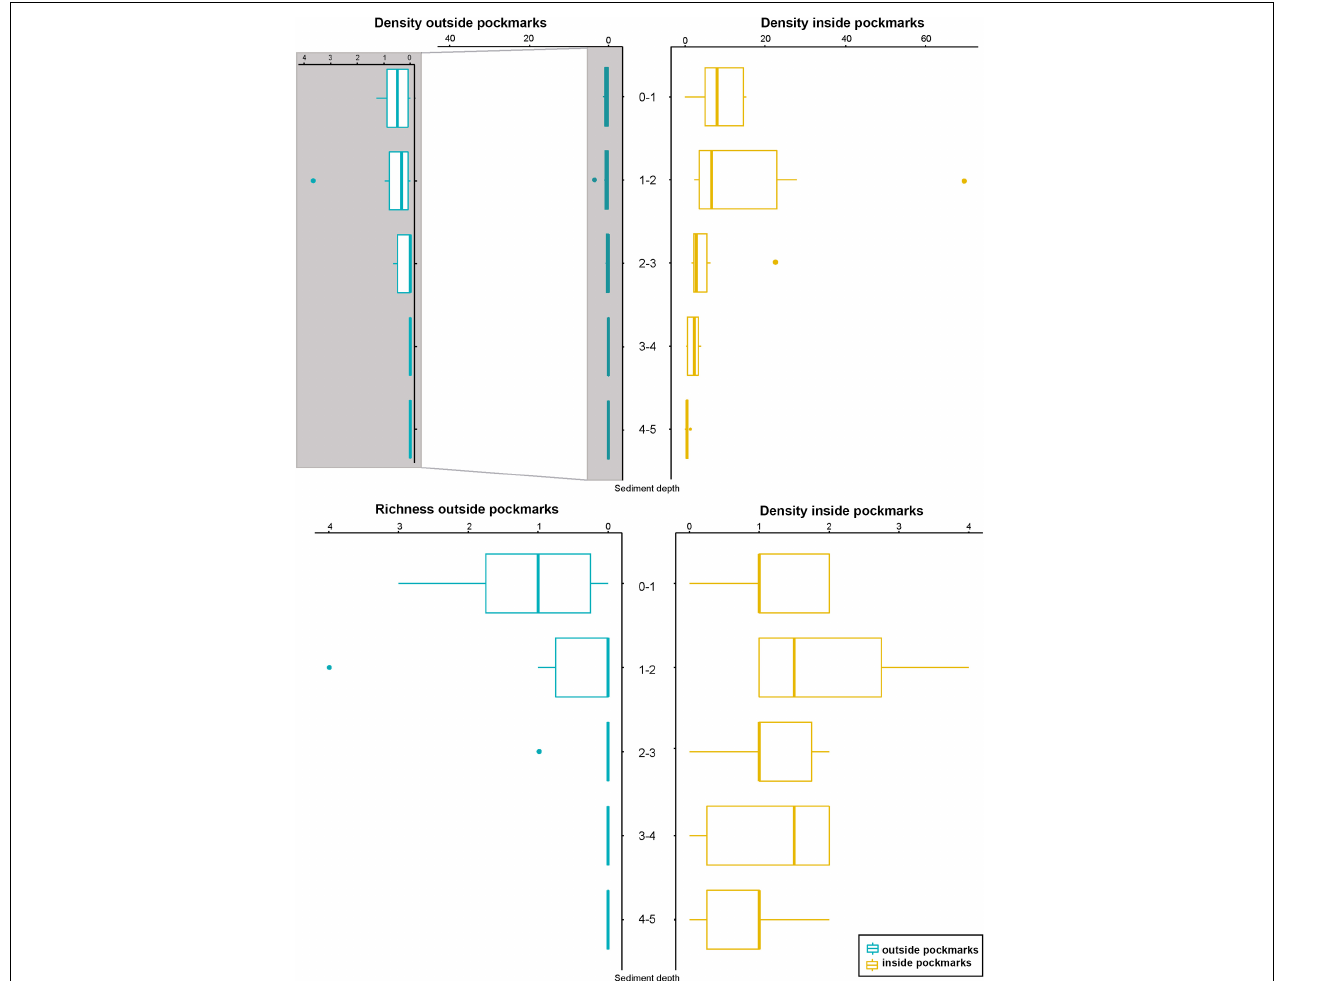
FIGURE 10 | Kinorhynch density and richness along the vertical profile of the two study habitats, inside pockmark (yellow) and outside pockmark (blue). Image enlargement of density outside the pockmark is provided to allow discerning variation of kinorhynch densities along the vertical profile. Boxplots represent the median value (horizontal line within the box), the distributions of 50% of the data (the box), and the highest and lowest values within 95% of the distribution (the